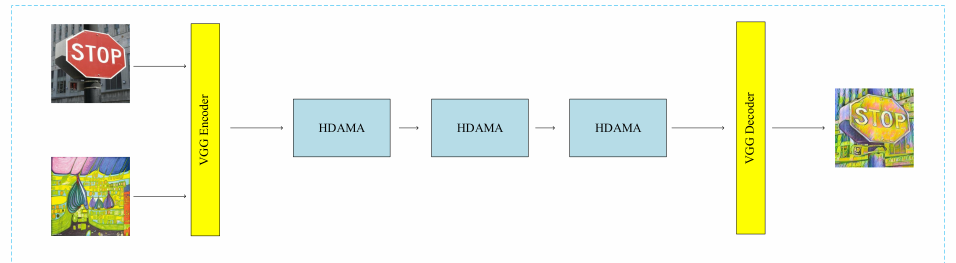
Figure 2. The overall structure comprises an encoder–decoder structure, where content and style maps are input to extract features through the VGG encoder; then, manifold alignment operation occurs through the three HDAMA modules, and finally a stylized image is generated through VGG decoder